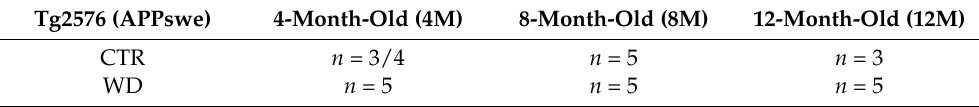
Table 2. Number of animals per group in transgenic Tg2576 (APPswe)